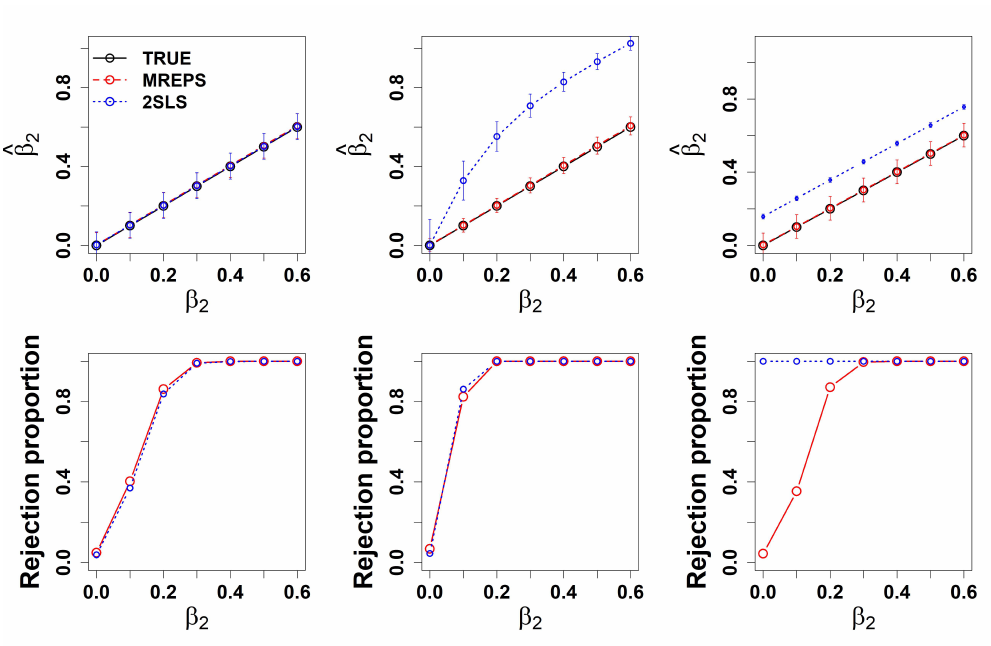
Figure 1. ( Top ) panel: comparison of estimators obtained via MREPS and 2SLS under the ran- dom ( left ), EPS Y ( middle ) and EPS X ( right ) designs. ( Bottom ) panel: rejection proportion of H 0 comparison for MREPS and 2SLS under the random ( left ), EPS Y ( middle ) and EPS X ( right )